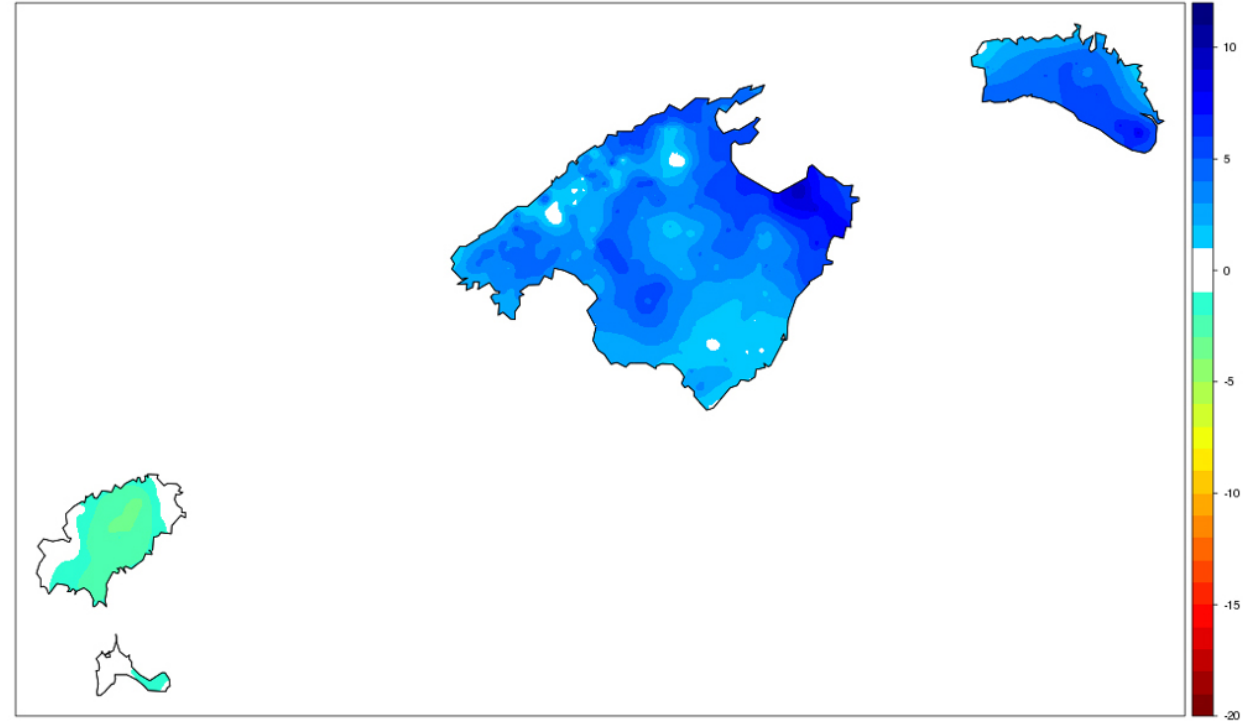
Figure 10. Trend of the monthly precipitation (mmdecade − 1 ) for November in the period